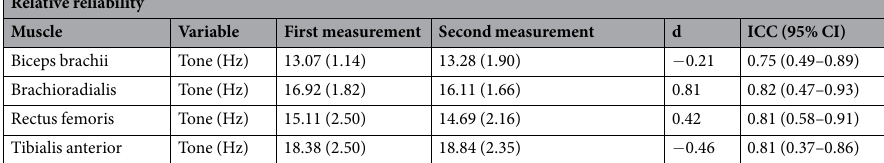
Table 2. The between-rater mean difference and ICC index. Key: d – mean difference between first and second measurements .